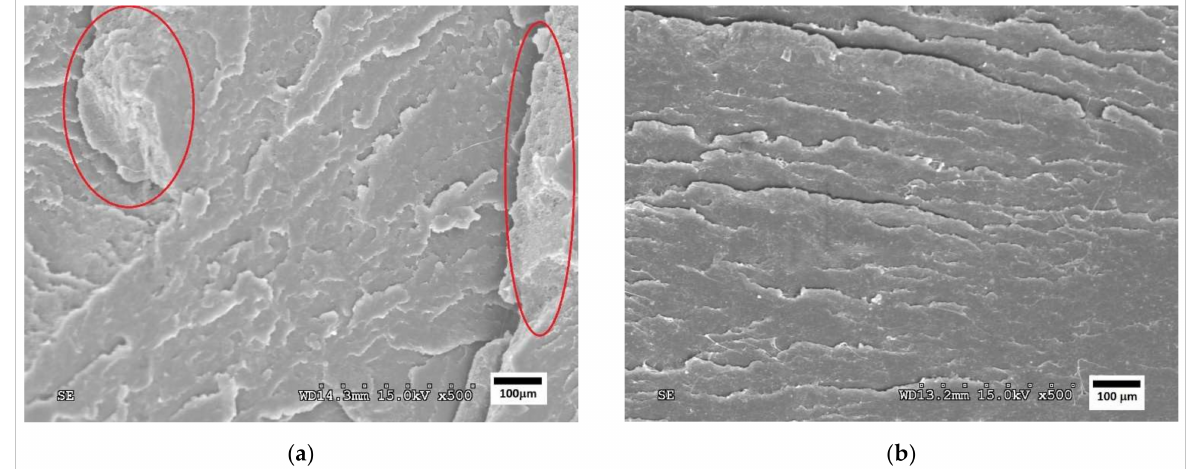
Figure 4. SEM micrographs of fractured surfaces at 500 × of ( a ) PLA80PBS20 and ( b ) PLA60PBS40